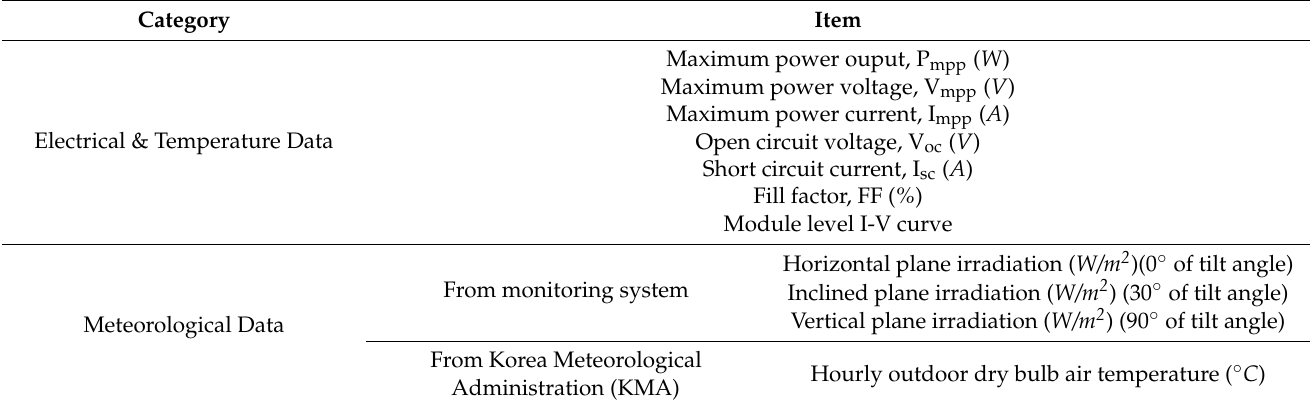
Table 2. Measured parameters of the monitoring system